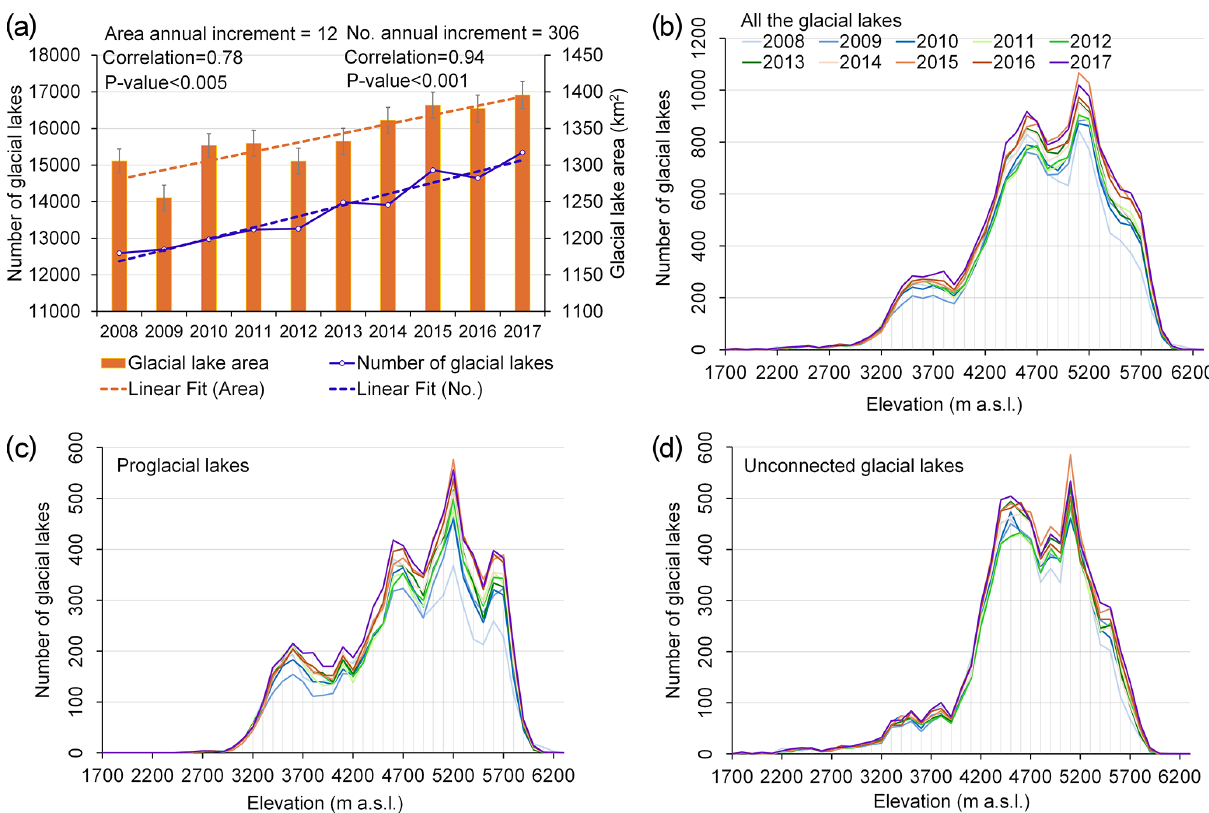
Figure 5. Numbers and total areas of glacial lakes for different years. (a) Total number and area of glacial lakes for HMA in the period 2008–2017. The annual increment is the slope of the trend of annual lake area and number. Altitudinal distribution (100m bin sizes) of lake numbers for (b) all glacial lakes, (c) proglacial lakes, and (d) unconnected glacial lakes.